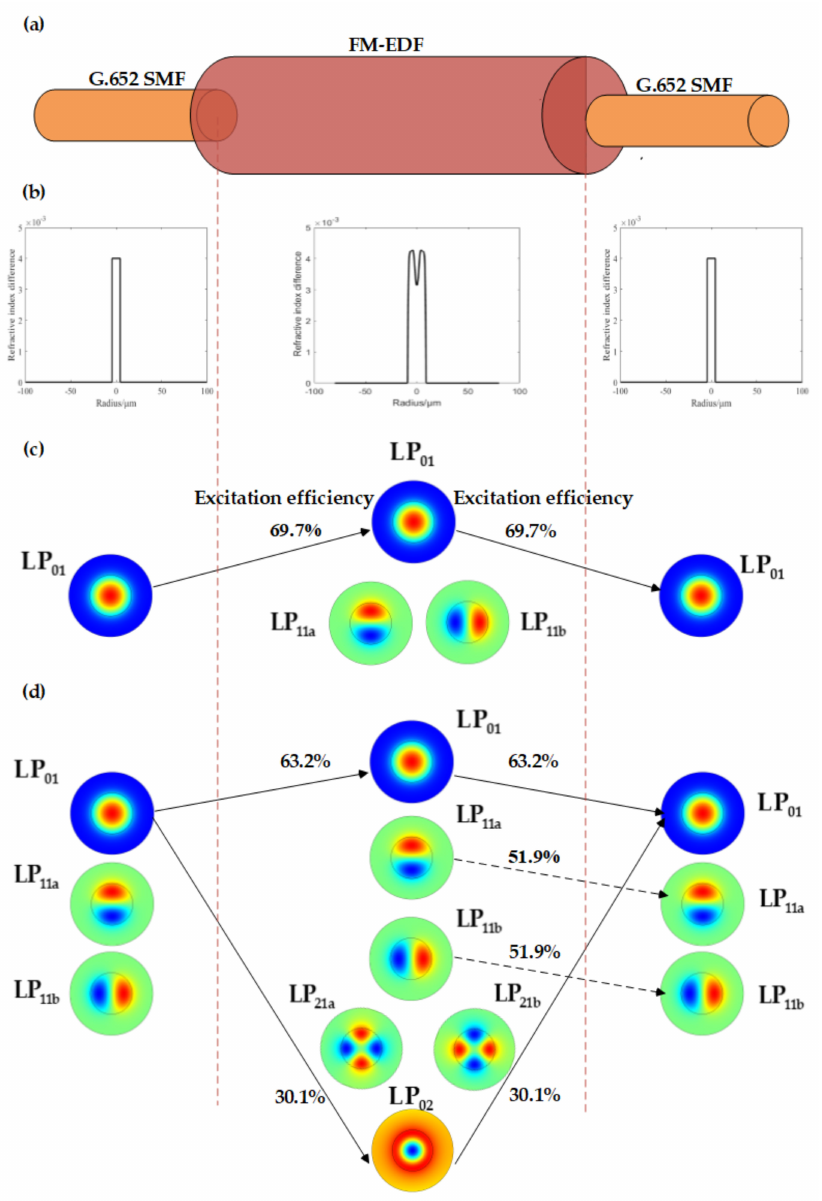
Figure 2. Spatial modes supported in the SMF and FM-EDF: ( a ) connection of single-mode pigtail and few-mode erbium-doped fiber; ( b ) the refractive index of the two fibers; ( c ) mode excitation process at a 1550 nm wavelength; ( d ) mode excitation process at a 980 nm